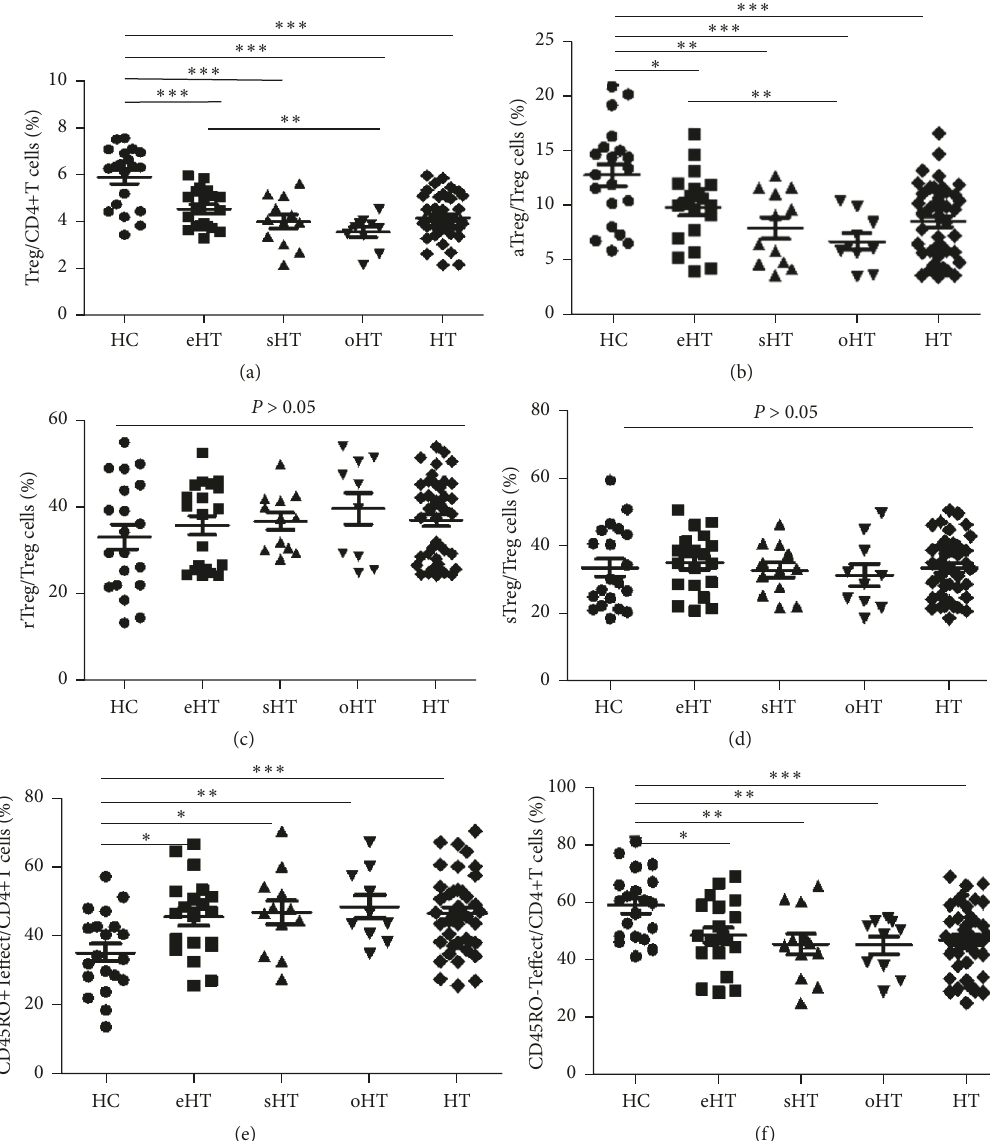
Figure 2: Differences of T lymphocyte subpopulations in HT patients and healthy controls. Percentages of (a) Treg in CD4 + T cell, (b) aTreg in Treg cells, (c) rTreg in Treg cells, (d) sTreg in Treg cells, (e) CD45RO + Teffect in CD4 + T cells, and (f) CD45RO −− Teffect in CD4 + T cells ( ∗ P < 0.05, ∗∗ P < 0.0075, ∗ ∗ ∗ P <